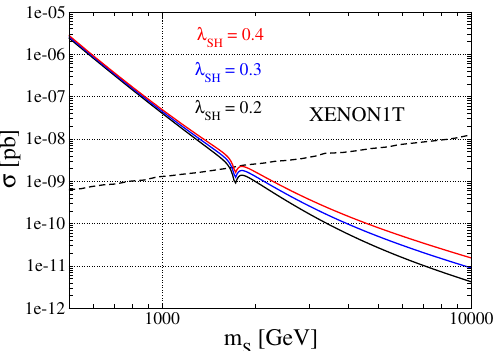
Figure 4 . Spin independent scattering cross section with a nucleon N as a function of the mass of DM m S in CP 2-2 with v φ = 3 TeV. The black, blue and red curve show the case with λ SH = 0 . 2 , 0.3 and 0.4, respectively. The dashed curve denotes the upper limit on the cross section at 90% confidence level given by the XENON1T experiment.